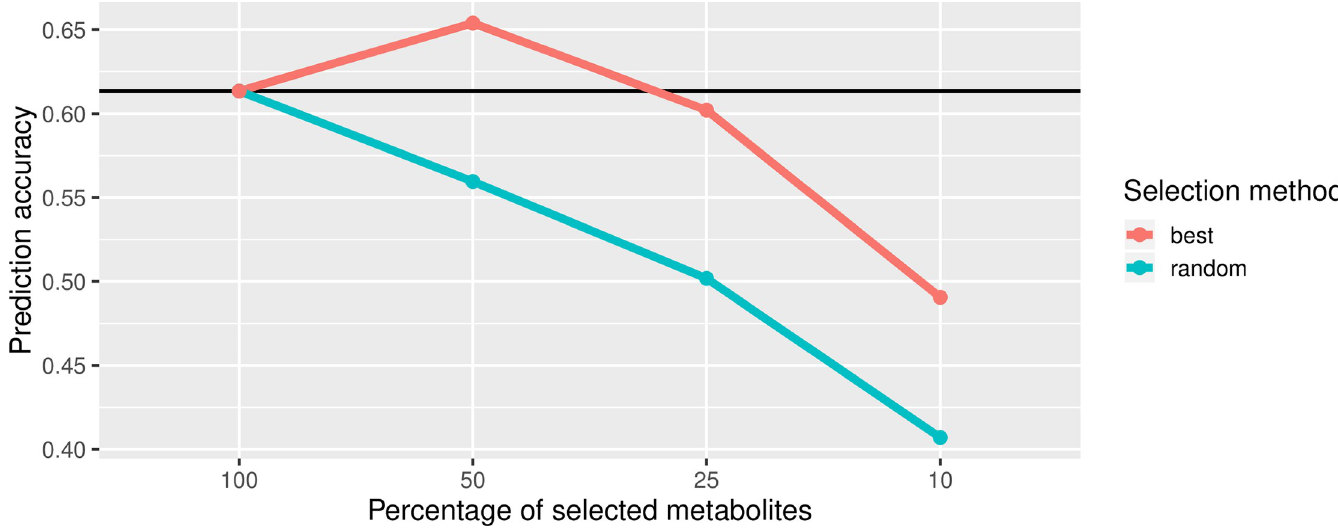
Fig 3. Variation of prediction accuracy for HEA with BayesB after reduction of the number of metabolites. The black reference line indicates the prediction accuracy using all metabolites in the model. The red line indicates the trend of prediction accuracy by selecting the best metabolites (metabolites with the highest effects in BayesB model), the blue line indicates the trend of prediction accuracy by selecting random metabolites.